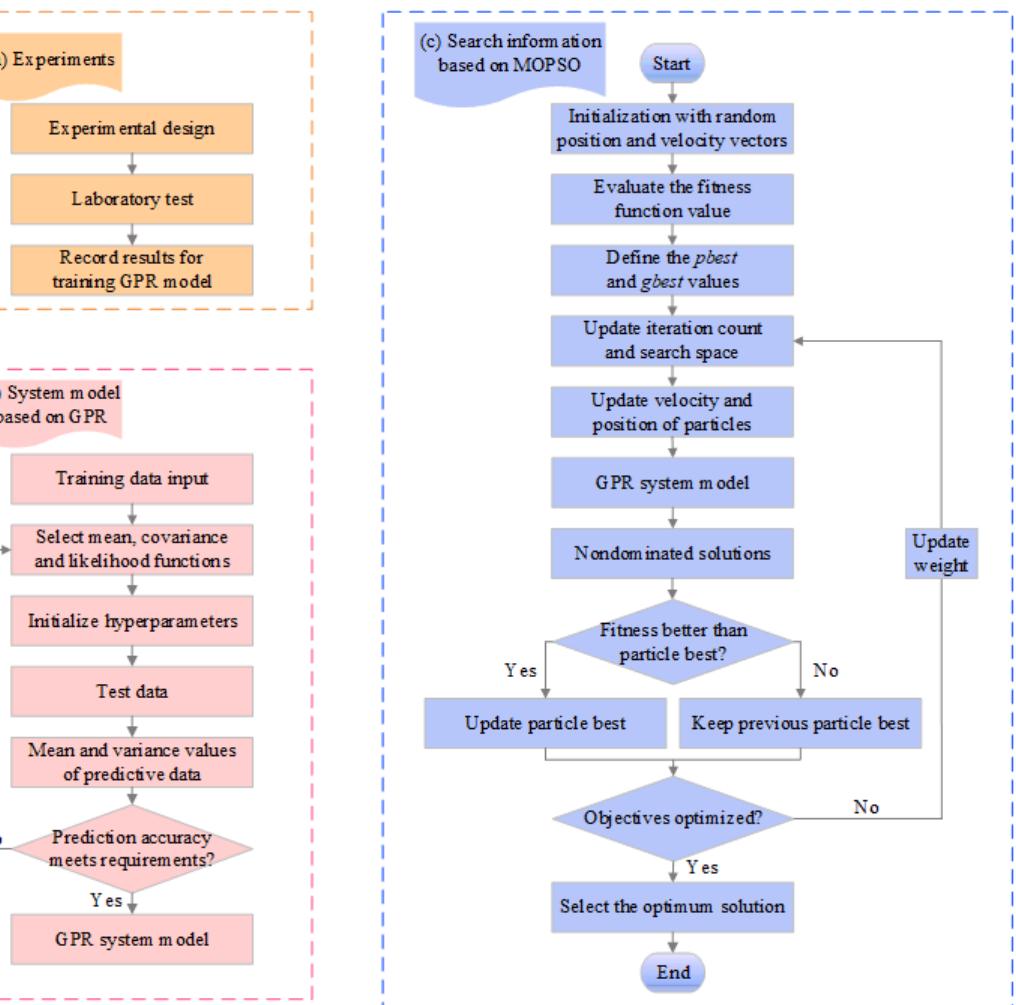
Figure 4. The flowchart of the procedure of GPR-adaptive weight multi-objective particle swarm optimization (AWMOPSO): ( a ) Experiments; ( b ) System model based on GPR; and ( c ) Search information based on MOPSO.